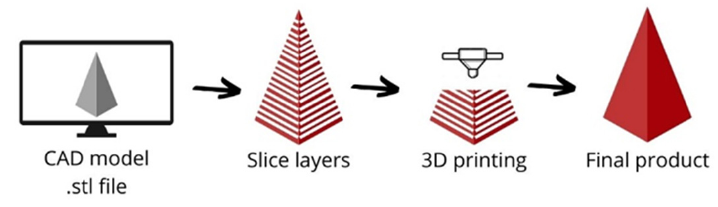
Figure 6. 3D printing process diagram.